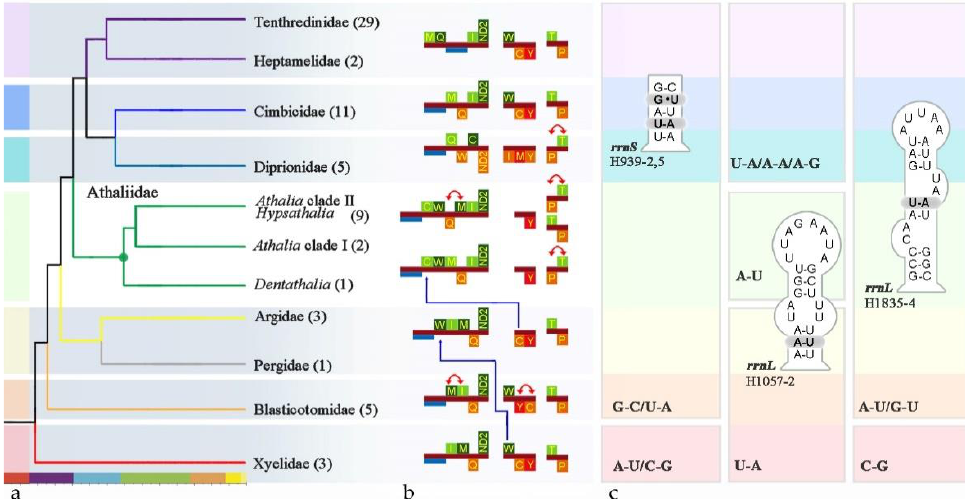
Figure 5. High-level taxon tree, gene rearrangement, and autapomorphic secondary structures of rRNA. ( a ) The dendrogram was simplified from the PCG dataset under the CAT-GTR model; numbers in brackets represent the mitogenome used in phylogenetic inference; ( b ) outline of rearrangement events across the Tenthredinoidea, with the blue lines indicating a major translocation and the red lines indicating a minor translocation; ( c ) group-specific structural characters of mt rrnL .